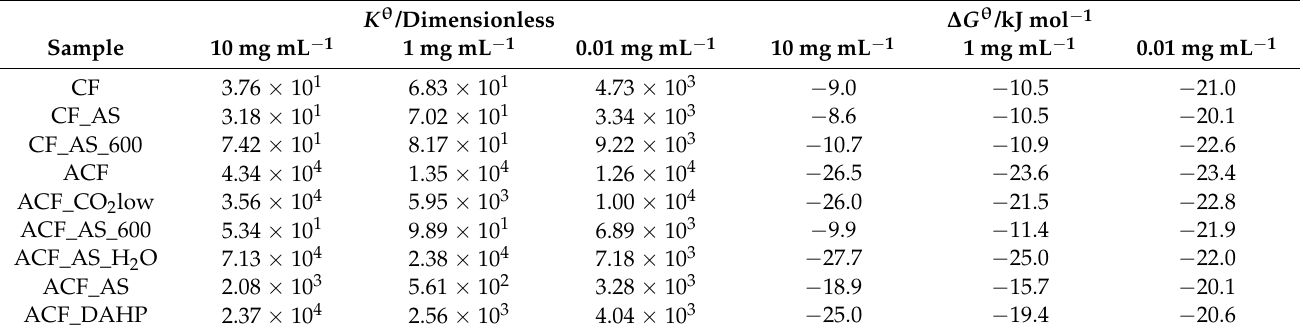
Table 7. Thermodynamic parameters, equilibrium constants ( K θ ), and Gibbs free energy of adsorption